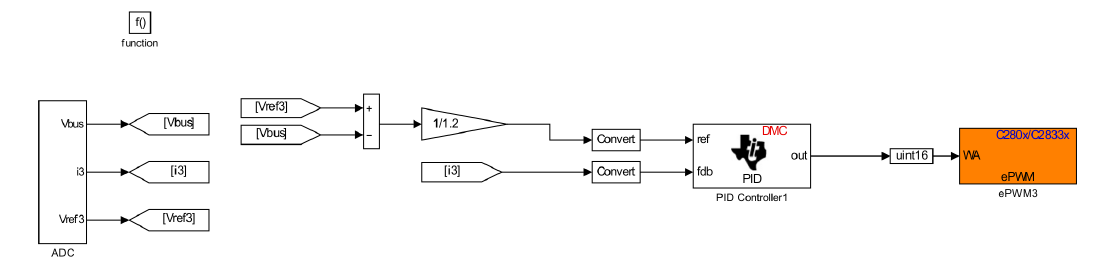
Figure 13. HIL controller for Source 3 (storage)–traditional droop.